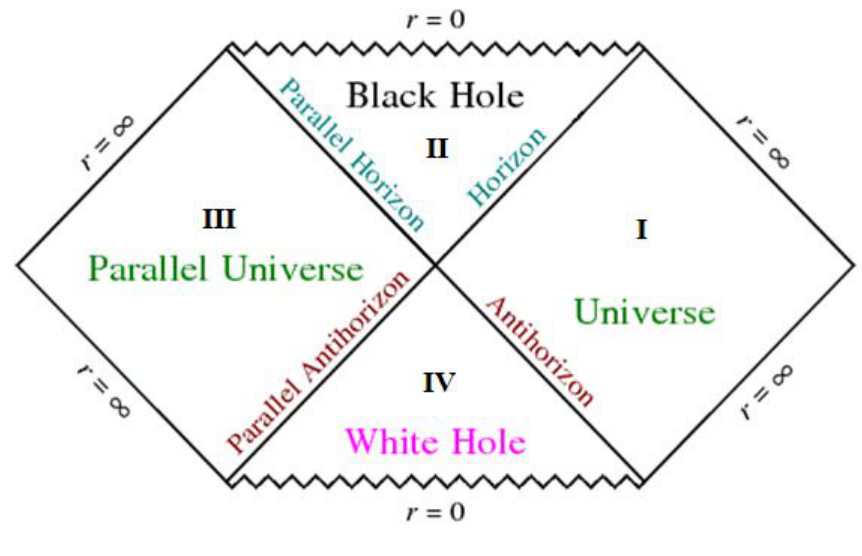
Figure 2. The four different regions of the Penrose